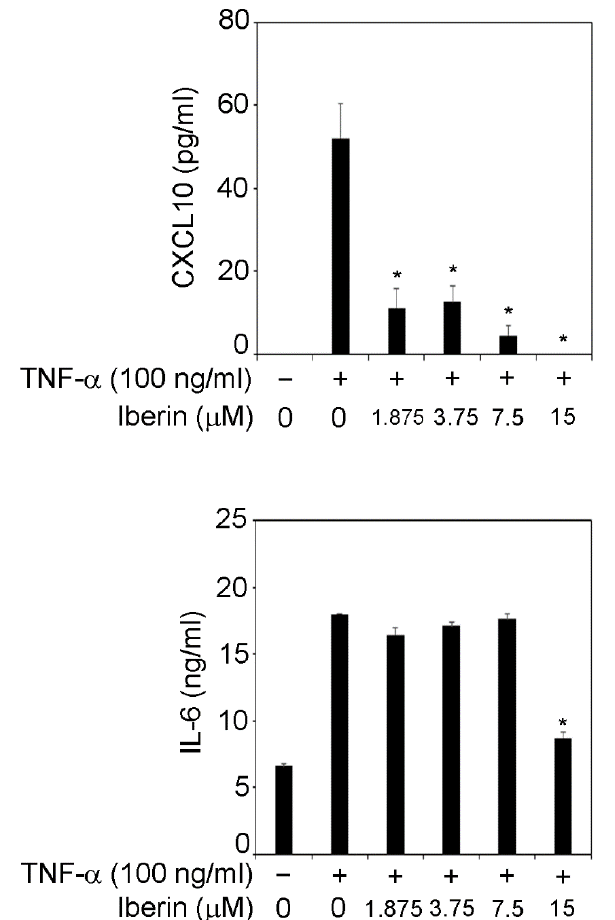
Figure 2. Effects of iberin on TNF- α -induced production of CXCL10 and IL-6. TR146 cells were grown for 24 h with TNF- α (100 ng/mL) with or without iberin (1.875–15 µ M). CXCL10 and IL-6 levels in the supernatant were measured using the ELISA kits indicated in the Materials and Methods section. The data are presented as the mean SD of three independent experiments. * = p < 0.05, significantly different from TNF ‐α‐ stimulated TR146 cells without iberin.